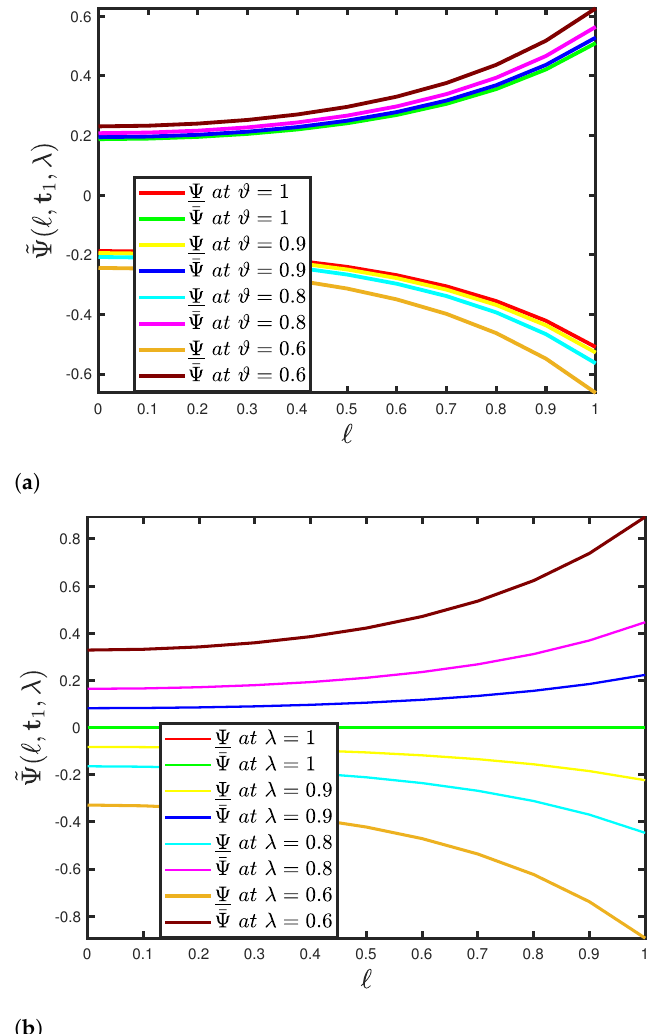
Figure 7. Two-dimensional simulation of ˜ Ψ ( (cid:96) , t 1 ; λ ) of Problem (2): ( a ) Ψ ( (cid:96) , t 1 ; λ ) and ¯ Ψ ( (cid:96) , t 1 ; λ ) when fuzzy ABC is considered to have an uncertainty parameter λ ∈ [ 0,1 ] and t 1 = 0.7; and ( b ) Ψ ( (cid:96) , t ) and ¯ Ψ ( (cid:96) , t ) when fuzzy ABC is considered to have a fractional order ϑ = 0.7 and 1 ; λ 1 ; λ t 1 =